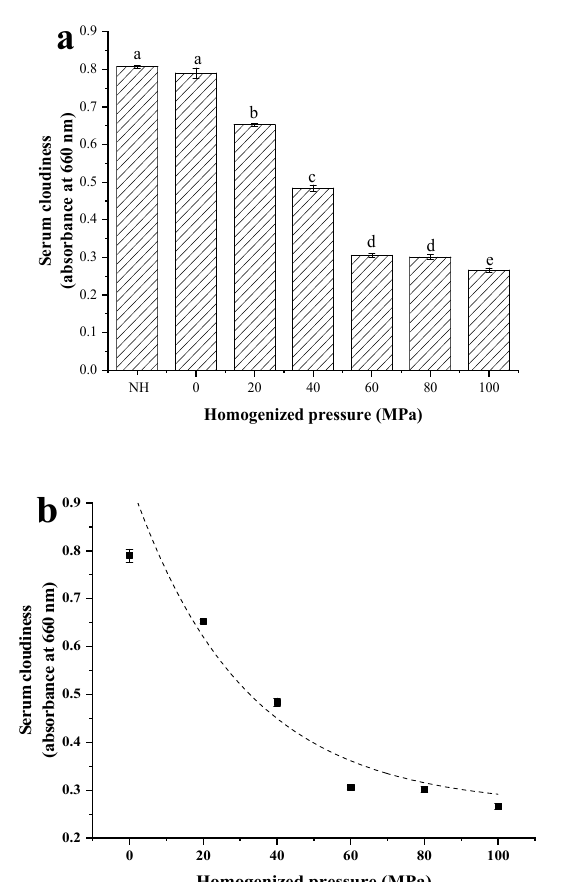
Figure 5. Effect of high-pressure homogenization on serum cloudiness (SC) of lily pulp ( a ) and the dashed curve is SC of the pulps was modeled as a function of homogenization pressure ( b ). Different letters in the column indicated that the samples were significantly different (p < 0.05).